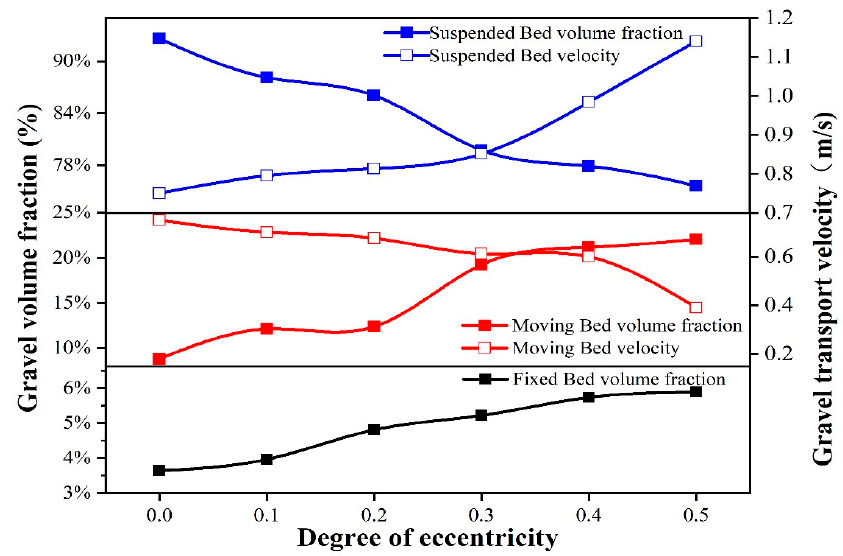
Figure 18. Graph of the effect of string eccentricity on volume fraction and migration velocity.